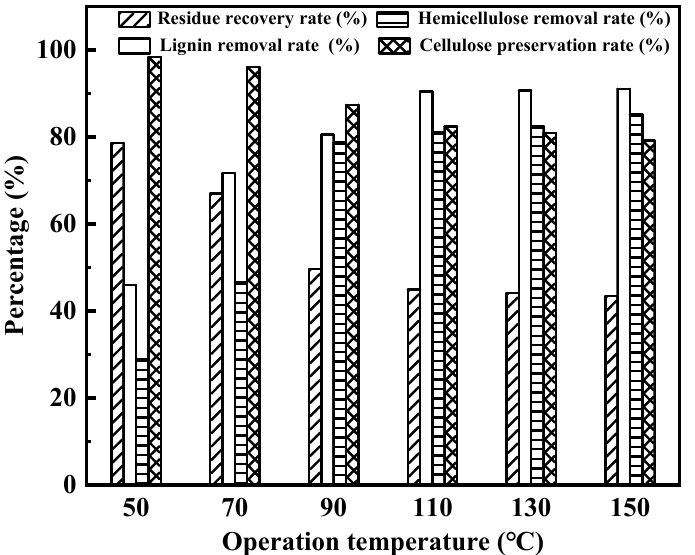
Figure 5. In fl uence of operation temperature on enhancing enzymatic hydrolysis of wheat straw. Figure 5. Influence of operation temperature on enhancing enzymatic hydrolysis of wheat